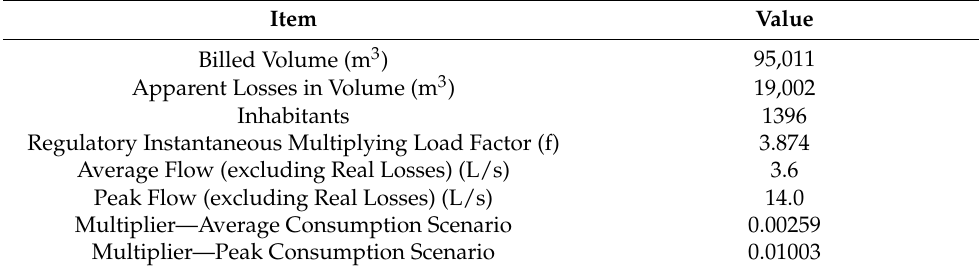
Table 2. Multipliers of the hydraulic